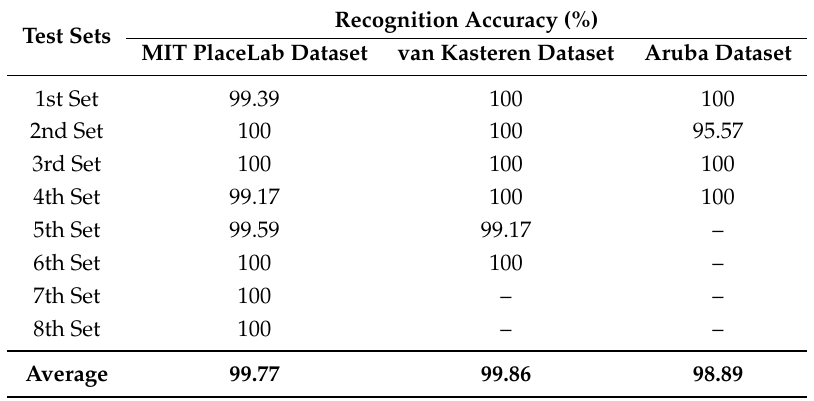
Table 5. Recognition performance in predicting user activity based on location for each test